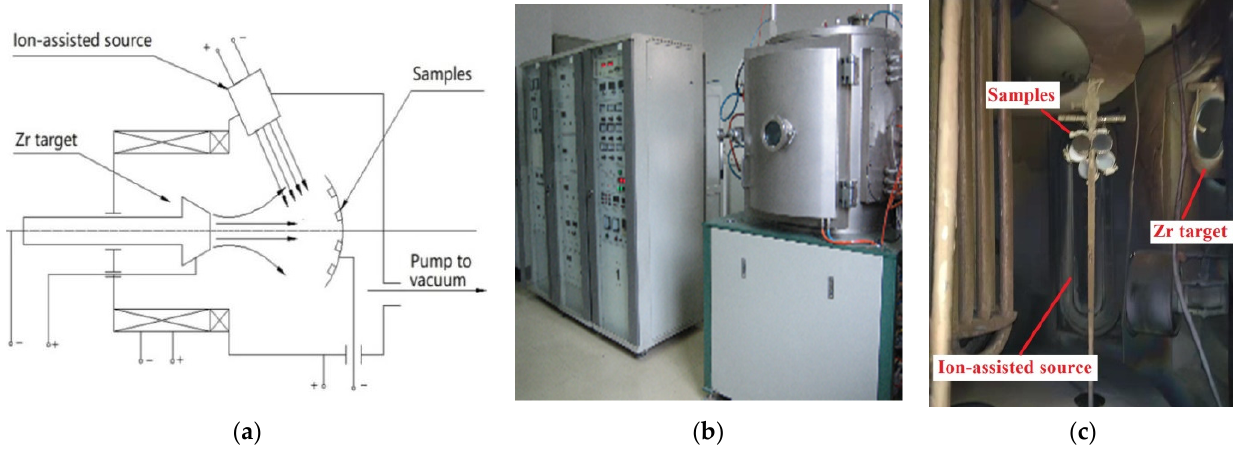
Figure 1. PIEMAD-03 ion-assisted multi-arc deposition system: ( a ) Schematic diagram, ( b ) photos of instruments, ( c ) corresponding components.